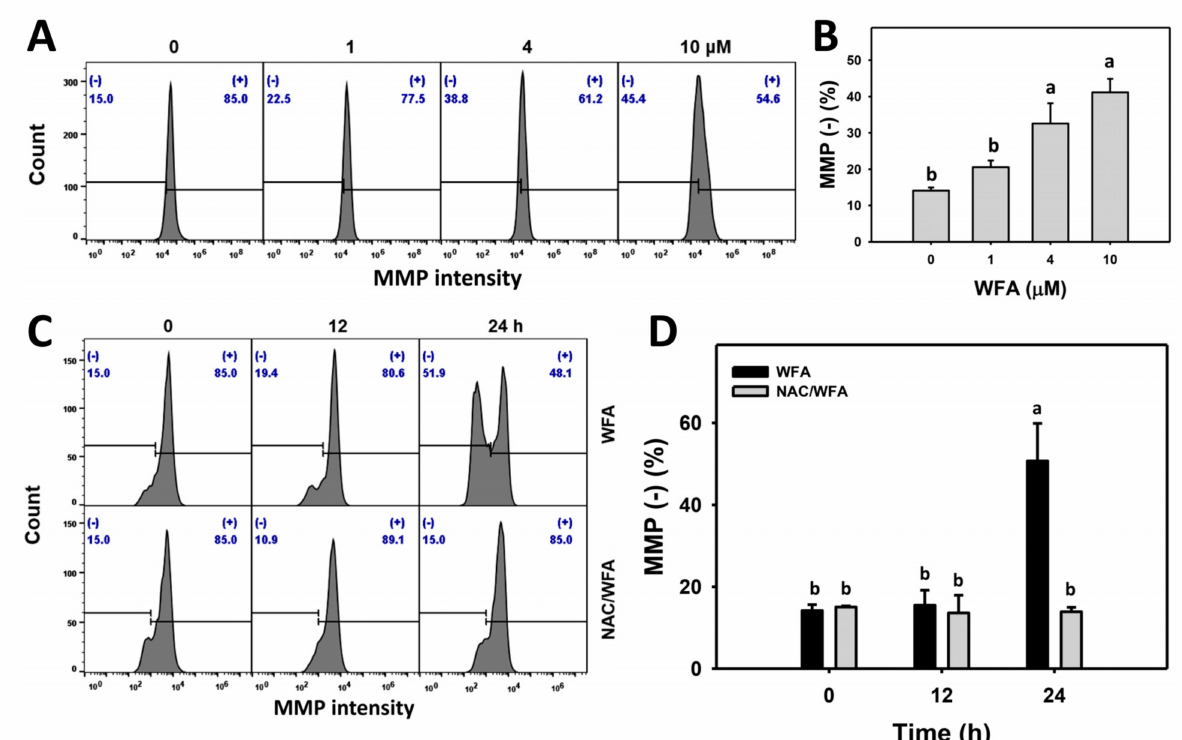
Figure 6. WFA induces MMP impairment in bladder cancer cells. ( A , B ) Patterns and statistics for MMP change. Bladder cancer cells (J82) were treated with WFA (24 h, 0 to 10 µ M), where the negative control for WFA (0 µ M) contained 0.1% DMSO. Symbol (-) indicates MMP (-). ( C , D ) The pattern and statistics for the NAC pretreated effect on MMP expression of J82 cells following WFA incubation. Cells were pretreated and post treated with NAC (8 mM, 1 h) and WFA (0 and 10 µ M for 12 and 24 h), respectively. Data, mean ± SD ( n = 3). Columns showing non-overlapping lower-case letters indicate p < 0.05 for multiple